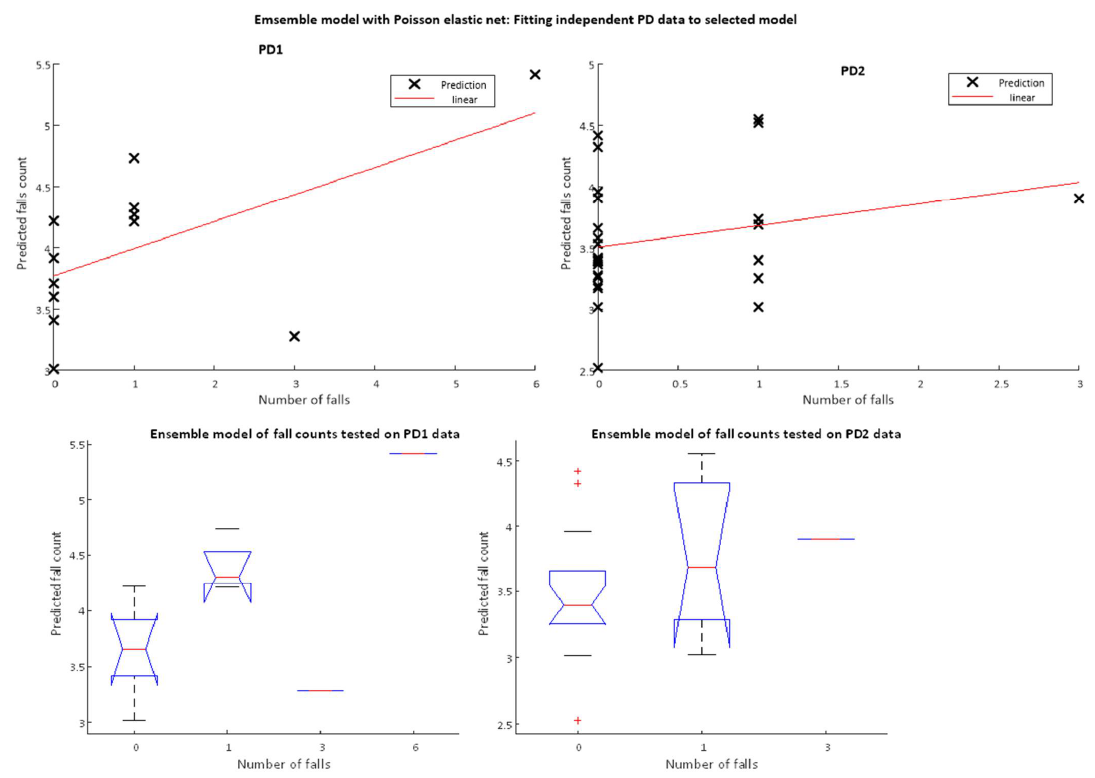
Figure 5. Testing ensemble model on independent PD datasets. Ensemble model is trained using TD-NoPD and TD-Faller-No-PD datasets and validated on TD-PD dataset.